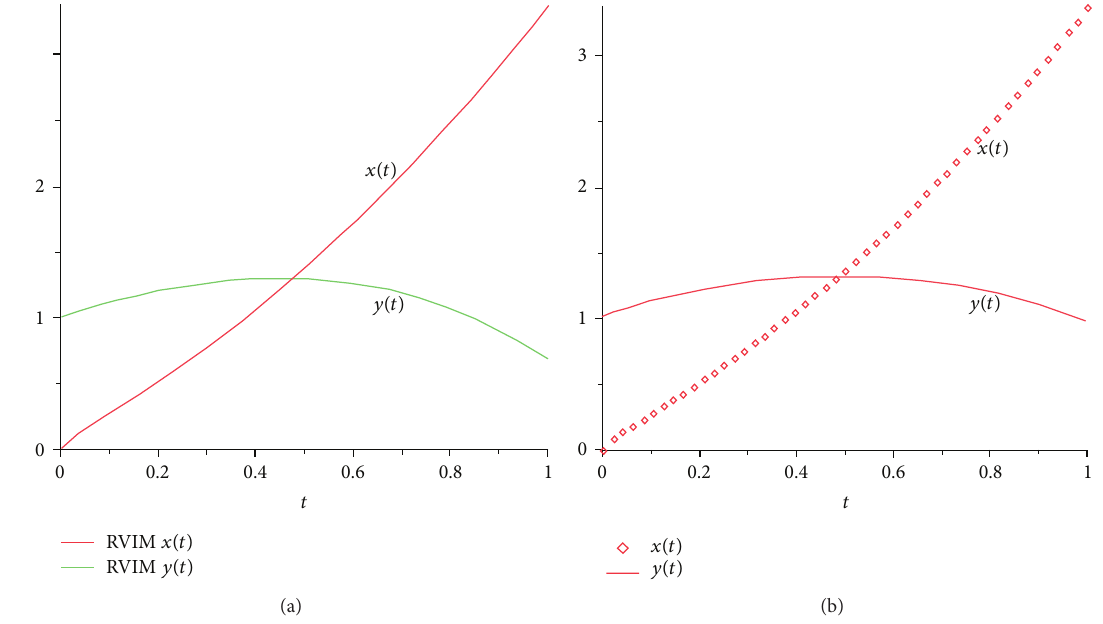
Figure 2: Plots of system (17), when 𝛽 = 0.7 , 𝛾 = 0.9 : (a) RVIM method and (b) differential transform method.